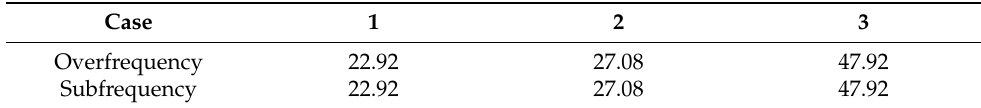
Table 3. Reduction (%) of the maximum rate of change of frequency (RoCoF) compared to the base case.